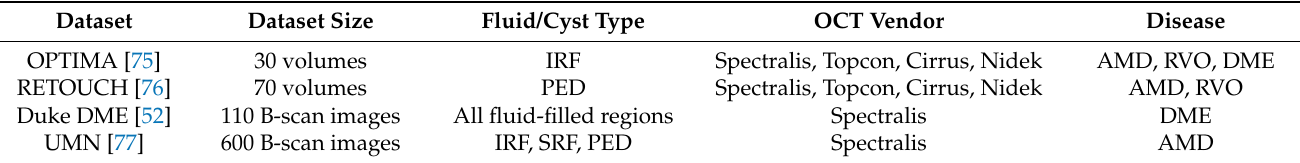
Table 4. Public OCT datasets for retinal cyst/fluid